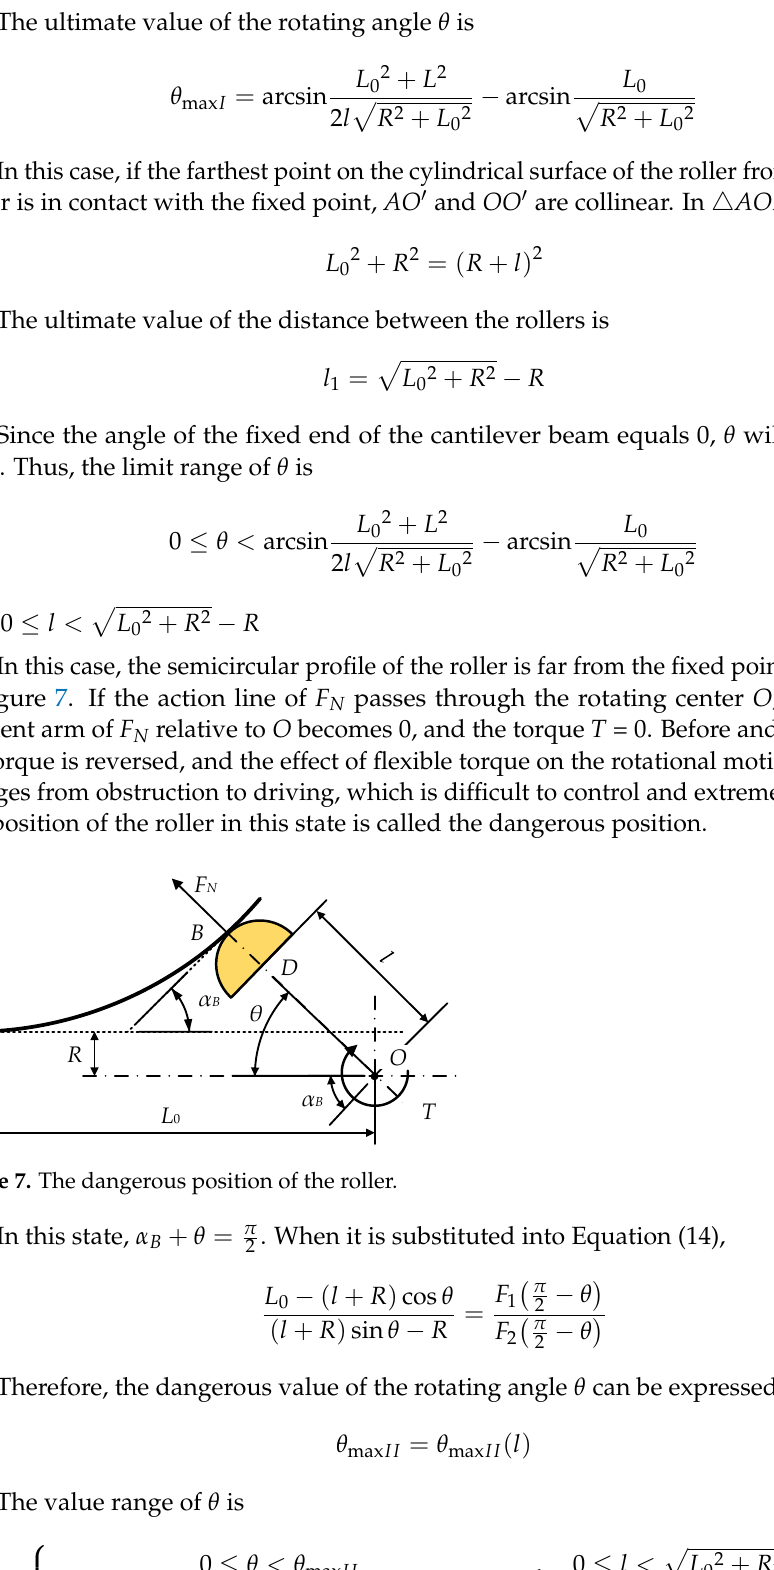
Figure 6. Ultimate position of the roller.